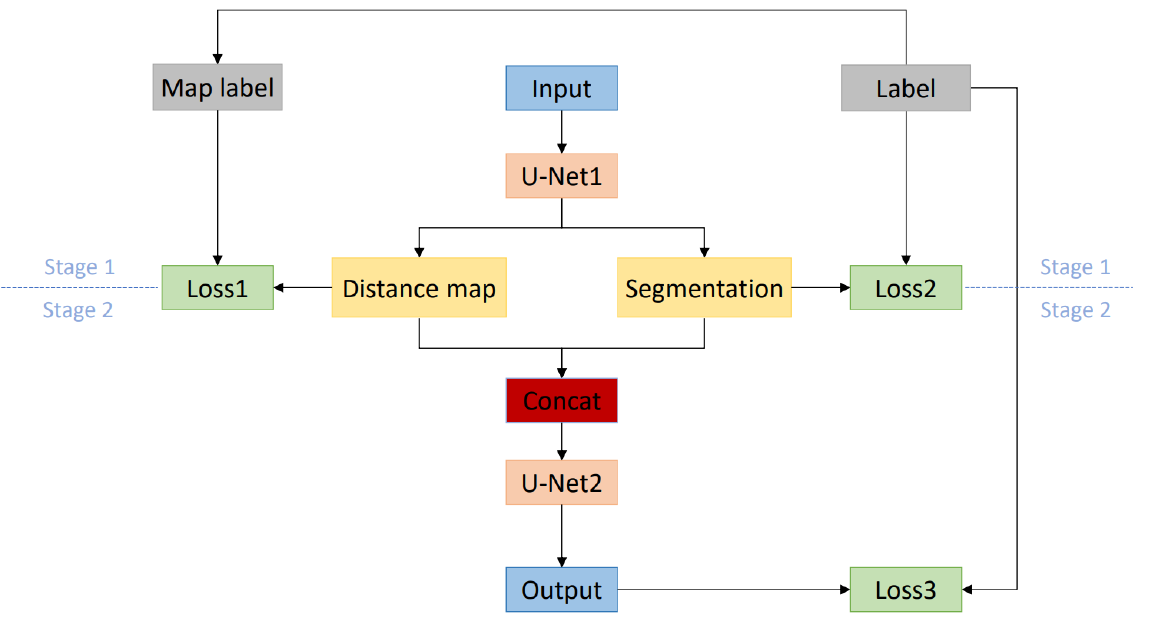
Figure 2. Schematic diagram of the overall network